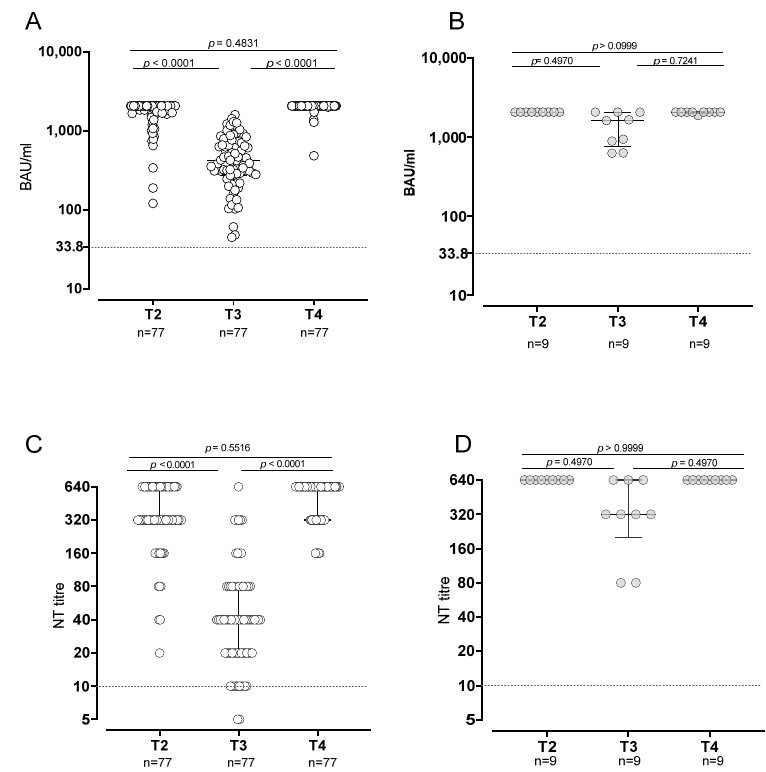
Figure 1. Humoral response in SARS-CoV2-naïve and -experienced vaccinated subjects. Levels of anti-spike antibodies in SARS-CoV2-naïve ( A ) and -experienced ( B ). SARS-CoV-2 neutralizing antibodies in -naïve ( C ) and -experienced ( D ) subjects.